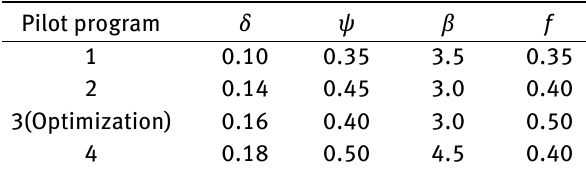
Figure 8: The comparison of residual contact